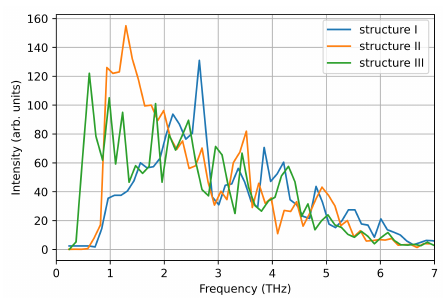
Figure 9. Vibrational density of states computed from the velocity auto-correlation function in LAMMPS